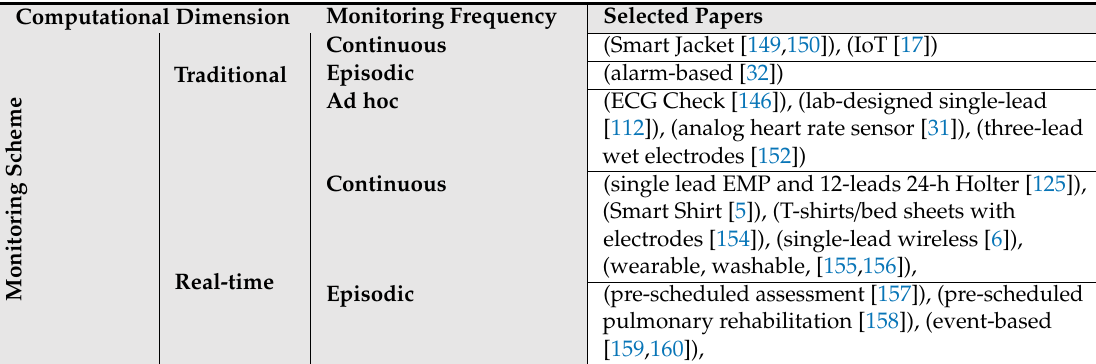
Table 4. Classification of ECG monitoring systems based on scheme and